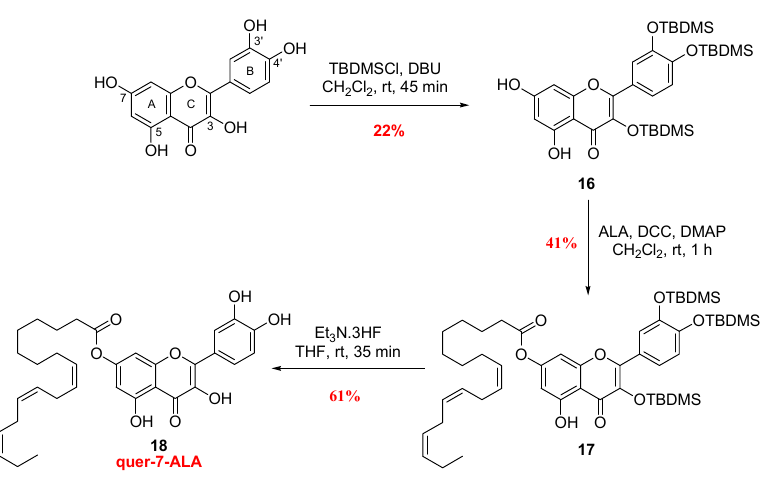
Figure 5. Synthetic pathway to access quercetin-7-ALA.